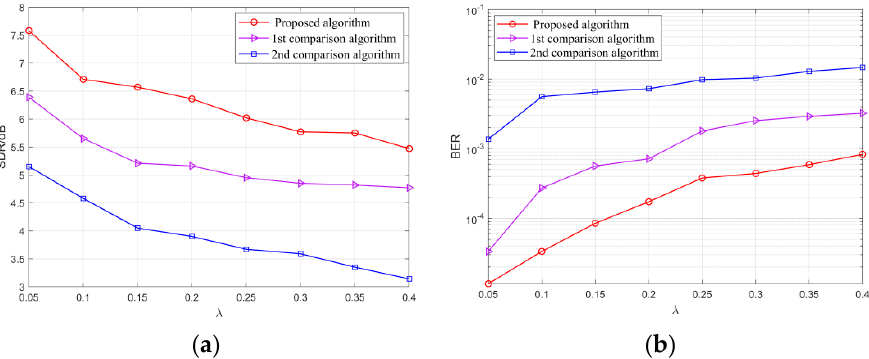
Figure 13 . ( a ) The SDR of three BPSK signals with different λ ; ( b ) The BER of three BPSK signals with different λ . The 1st and 2nd comparison algorithms are given in literatures [8,10], respectively.